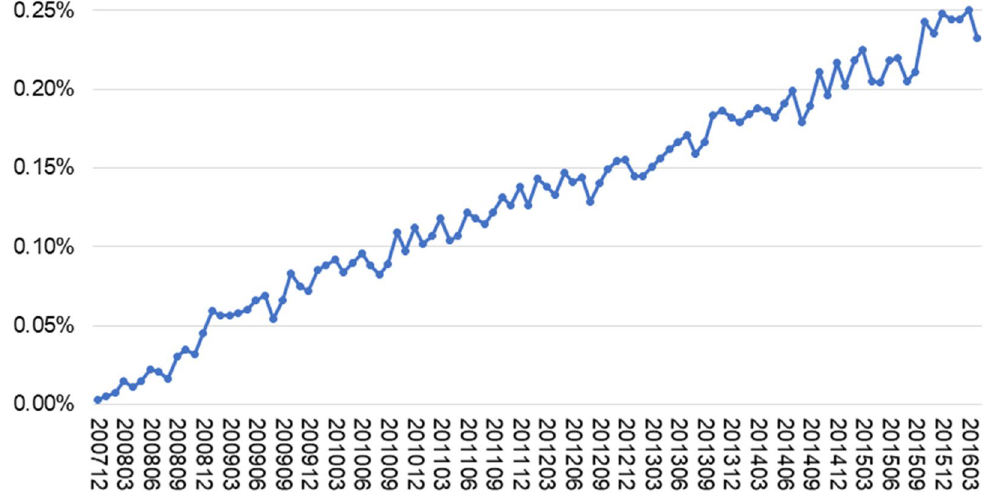
Figure 1. Prevalence estimates of OROS-MPH in the Japanese population aged 6–17 years. Prevalence estimates were corrected with population statistics issued by the statistics bureau of Japan (27). OROS-MPH, osmotic-release oral system methylphenidate hydrochloride.